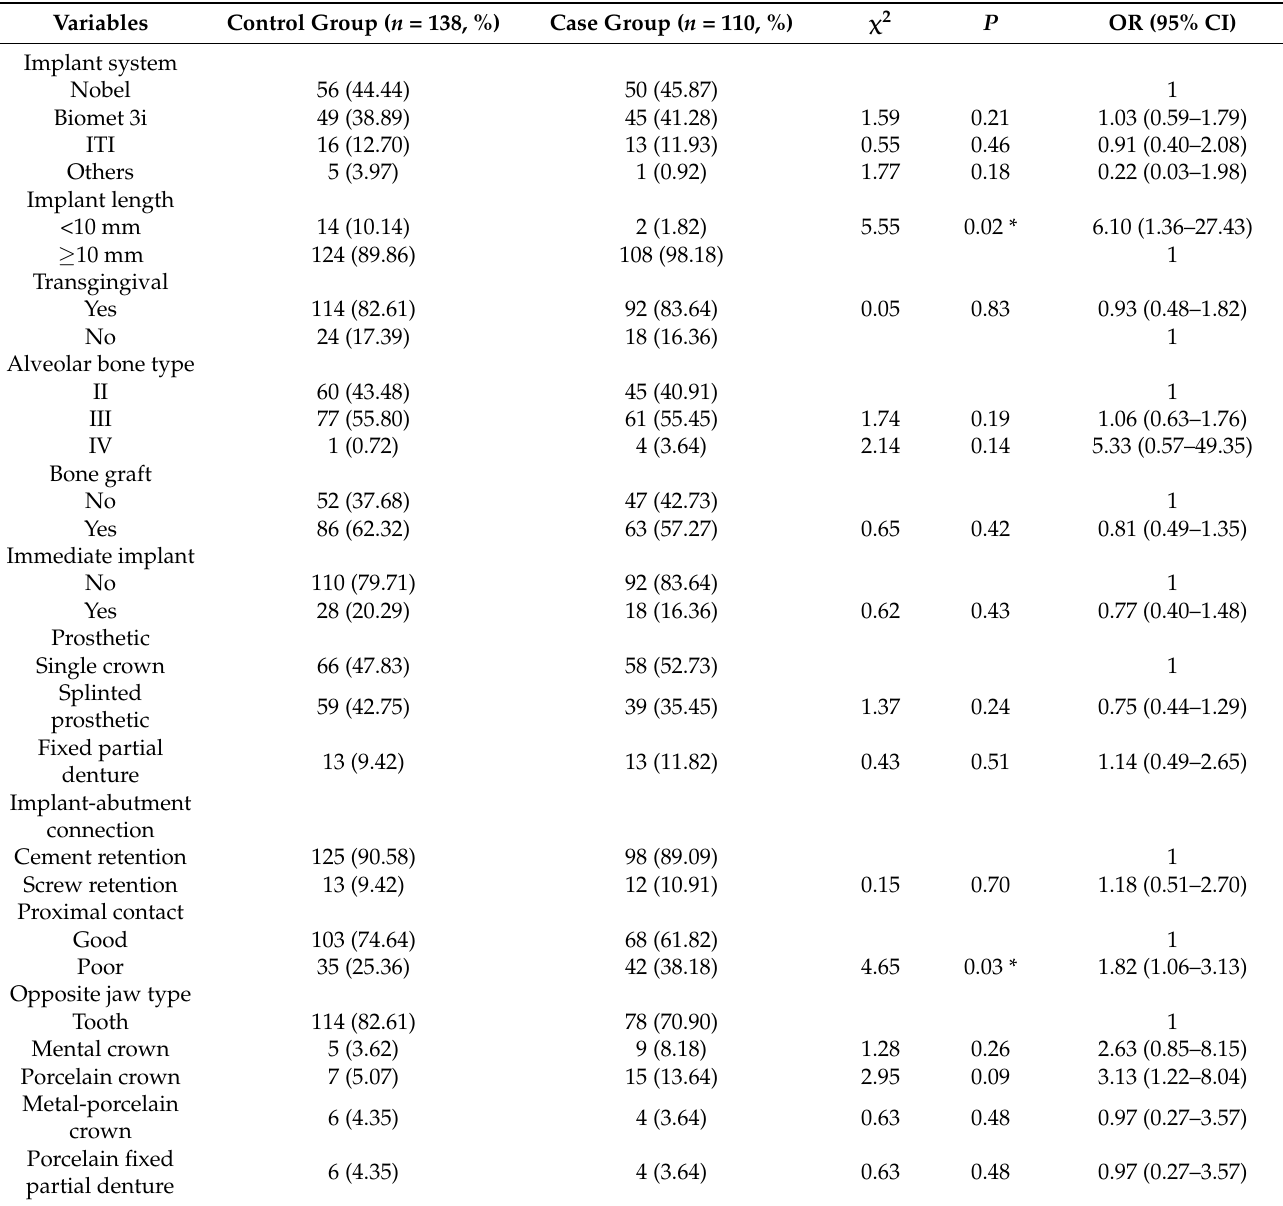
Table 2. Univariate Logistic regression analysis of implant-related